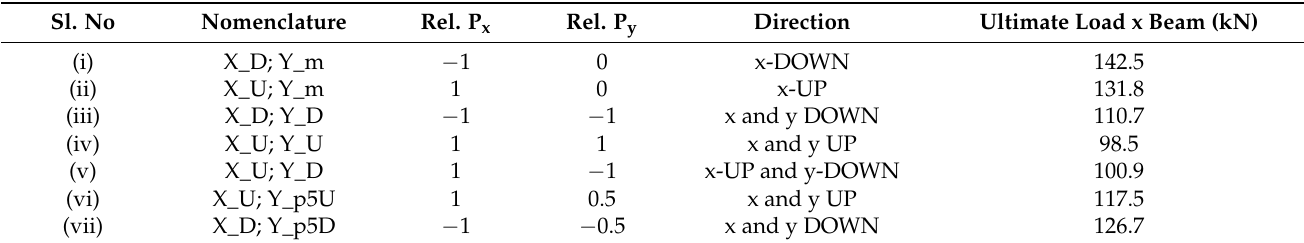
Table 2. Summary of results obtained for different cases considered in the parametric analysis. Sl.